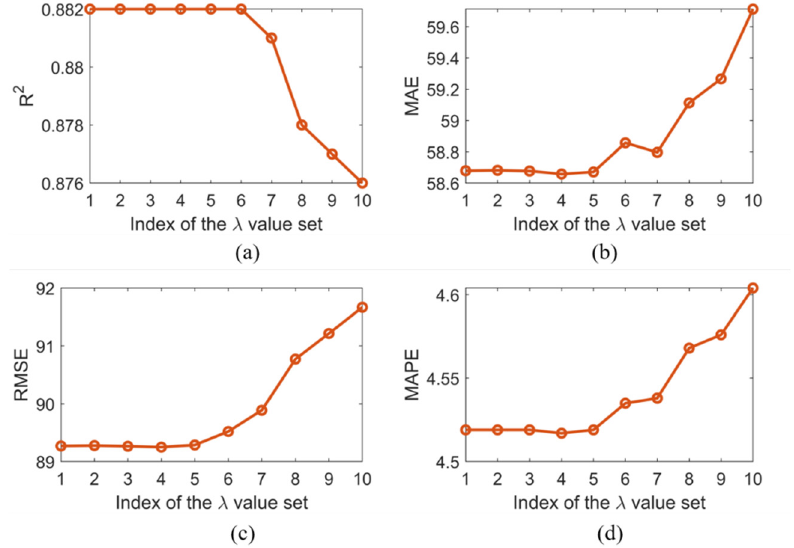
Figure 12. Sensitivity analysis on the regularization parameter, λ . ( a ) R2. ( b ) MAE. ( c ) RMSE. ( d ) MAPE.